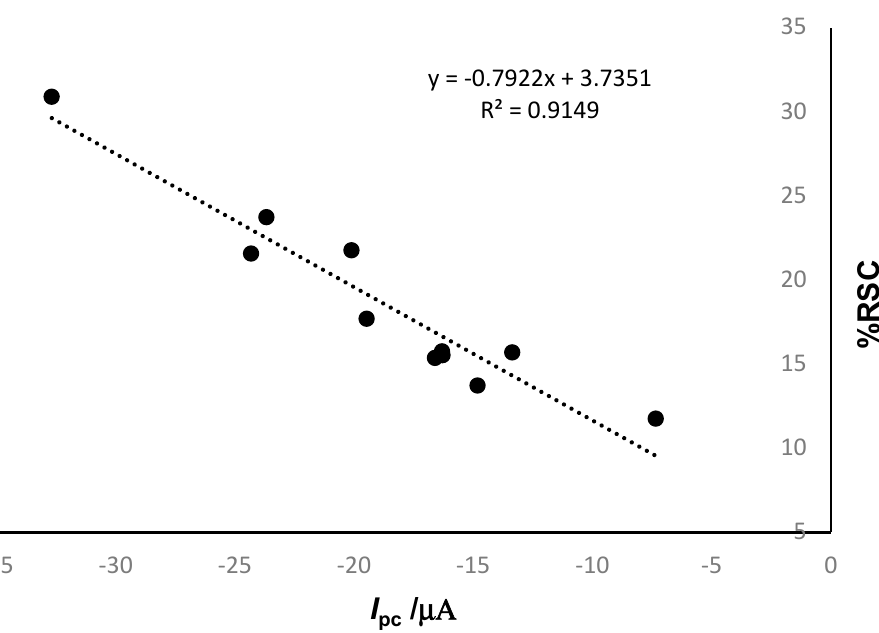
Figure 13. Correlation between RSC% and cathodic current related to HT reduction.